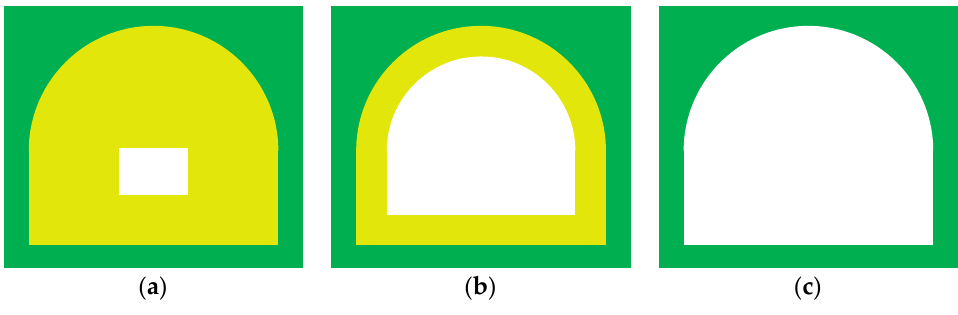
Figure 1. Blasting driving process of rock tunnels. ( a ) Cutting blasting. ( b ) Stopping blasting. ( c ) Contour blasting.